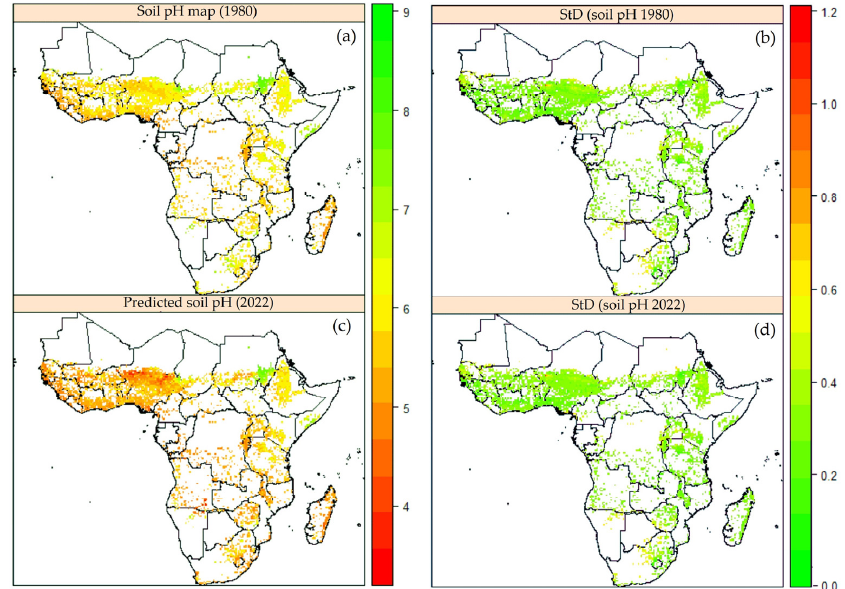
Figure 6. Spatial and temporal variations in soil pH in the last 42 years in SSA croplands. ( a ) Map of spatial patterns of soil pH in 1980, and ( b ) its uncertainties as a standard deviation map (pH units). ( c , d ) Map of current soil pH and its standard deviation map (pH units), respectively. The map of the current soil pH (Figure 6c) followed the same pattern as the soil map of 1980. The soil pH ranged from 4.5 to 8.6 and parts of Sudan, Niger, and South Africa were among the top countries with cropland areas with a high soil pH (above 8). Addi- tionally, the soil pH in these areas did not change in the 42 years from 1980 to 2022 (Figure 6a,c). The croplands with a soil pH ranging from 6 to 6.5 in 1980 experienced significant changes but the soil pH in these areas did not drop much in 42 years because in the 2022 soil pH map, the pH in these areas ranged from 5.5 to 6 (Figure 6c). The central and west- ern parts of SSA plus Madagascar had low soil pH (6–4.5). The current spatial variation is expected to change with future increases in the use of ammonium-based fertilizers and other soil acidification factors. The uncertainty map showed that the soil pH in 2022 was accurate, with a low standard deviation ranging from 0 to 1.2. However, almost all of the SSA standard deviation maps showed the soil pH ranging from 0 to 0.8 for both the past and current maps (Figure 6a,c). Figure 7 shows the predictions of the soil pH in the different scenarios. We compared the current spatial variation in the soil pH and its associated errors (Figure 7a,b) with the predicted soil pH maps in the BAU and EqD scenarios. The spatial variation in the soil pH in the BAU and EqD scenarios had the same spatial patterns as the past and current soil pH patterns but with different intensities. The predicted spatial variation in the soil pH is expected to be in the same range (8.6–3.9) as the current variation, and only the soil pH ranging from 6.5 to 5 is expected to change, especially in the central and eastern parts of SSA (Figure 7c). The standard deviation map of the soil pH in the BAU scenario ranged from 0.2 to 0.4 (Figure 7d). The map of the soil pH variation in the EqD scenario showed the same pattern as the map of the soil pH in the BAU scenario, with few differences, especially in the areas with a soil pH of less than 6.5; however, the areas with a high soil pH (>7.5) showed the same pattern and intensity as the soil map in 1980 (Figure 7e). The uncertainties of the soil pH in the EqD scenario showed that the soil pH map of South